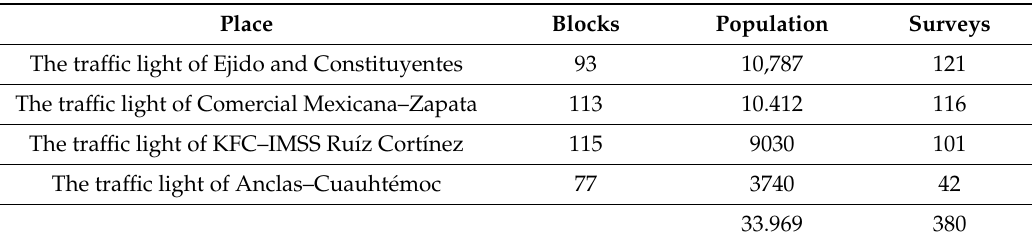
Table 4. Total number of surveys and each study